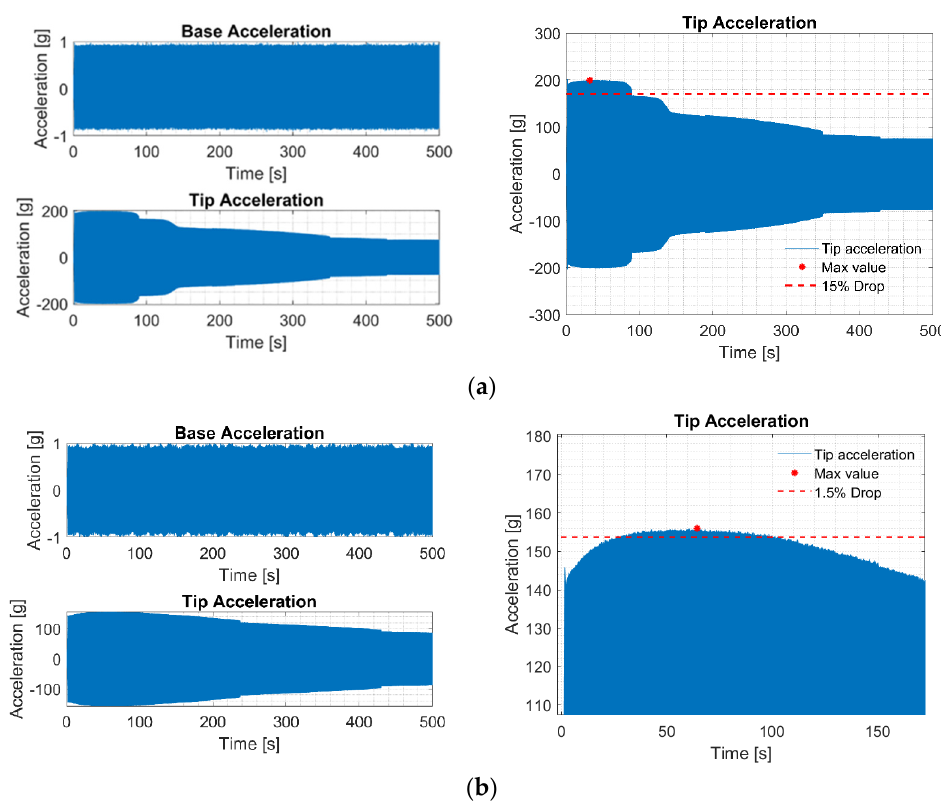
Table 7. Endurance tests results for the Diamond specimen. Specimen No.